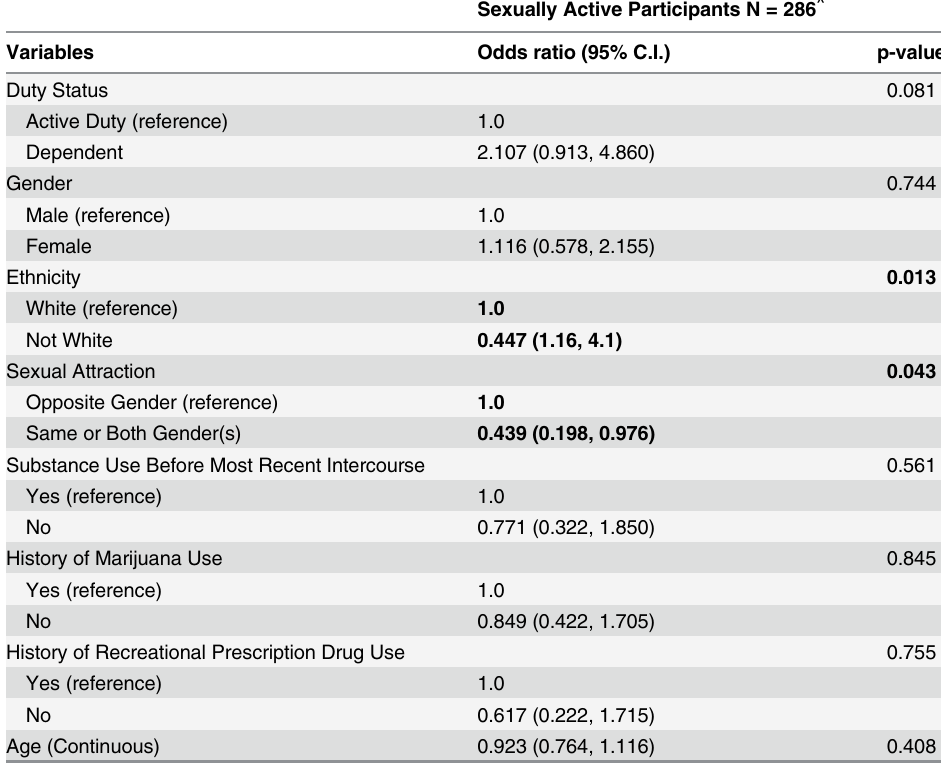
Table 5. Logistic regression analysis of prescription birth control or condom use during most recent intercourse among patients in military adolescent